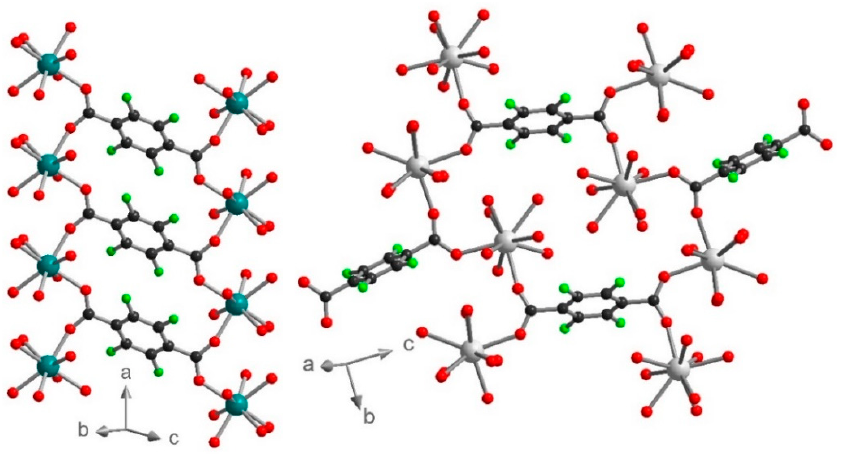
Figure 7. Coordination mode and orientation of the F 4 BDC 2 − ligands in 1 (left) and 3 (right). Color code: C (black), O (red), F (green), Yb (teal), Eu (grey). code: C (black), O (red), F (green), Yb (teal), Eu